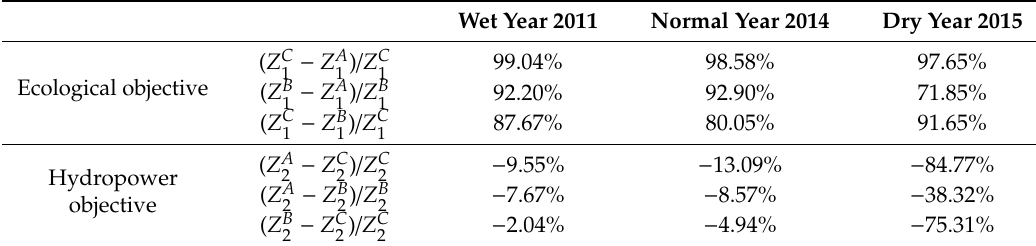
Table 5. Relationship between the recovery degree represented by ecological objective and the economic benefit represented by hydropower objective for di ff erent